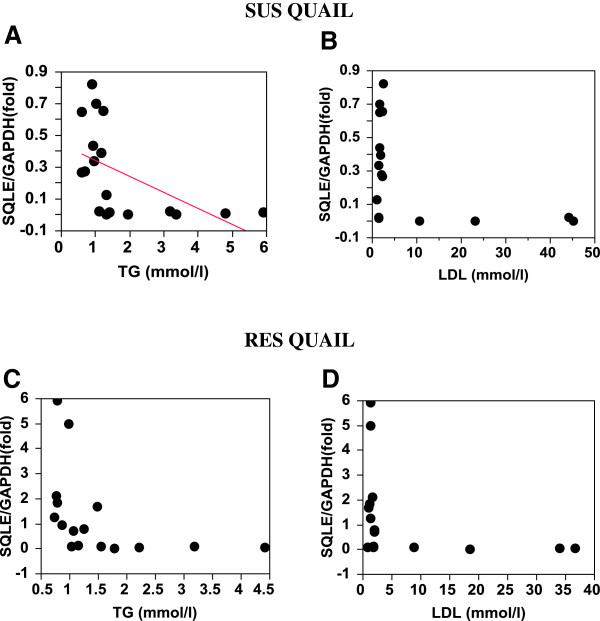
SQLEexpression in SUS and RES liver relative to plasma triglyceride and LDL levels. In part A: r2 = −0.29; P < 0.02.